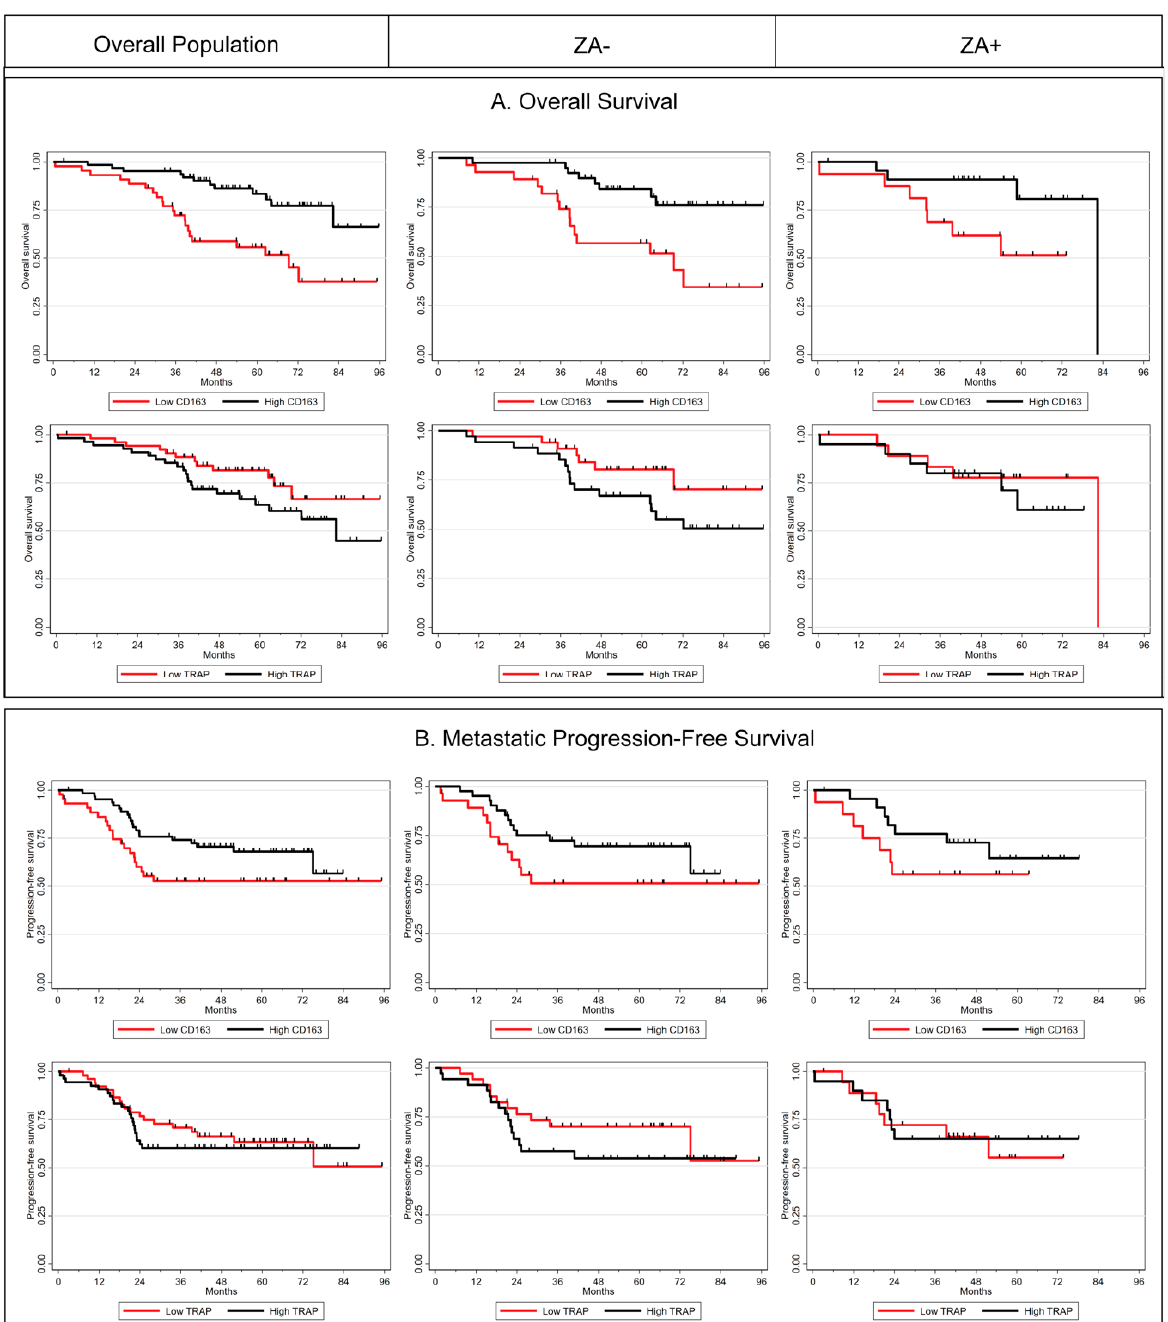
Figure 4. Kaplan-Meier curves according to CD163 and TRAP levels in the overall population ( left panel ), and in ZA − ( middle panel ) and ZA+ ( right panel ) groups for overall survival ( A ) and metastatic progression-free survival ( B ).